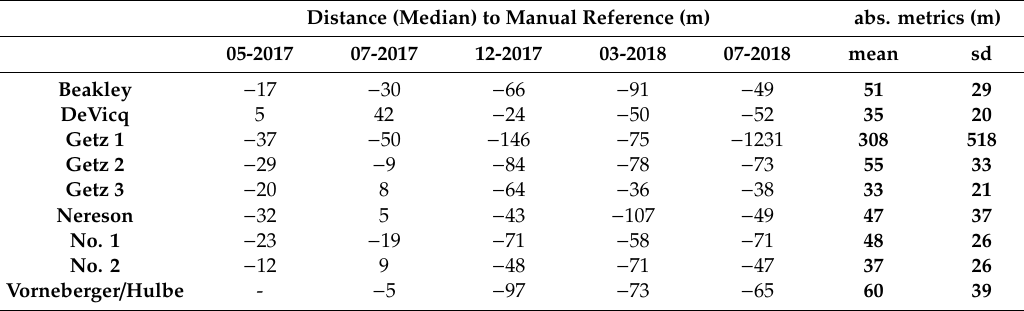
Table 4. Error calculation for the Getz time series with five manual reference coastlines. The distance to the reference coastlines is presented as the median of the measured transect